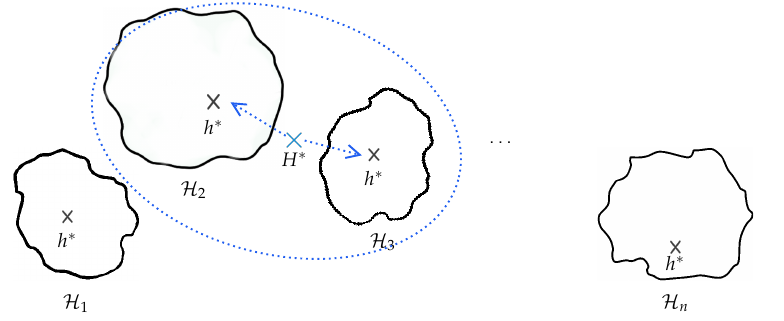
Figure 25. Illustration of the process of adaptation from the meta-hypothesis H ∗ towards a more appropriate hypothesis h ∗ (among those derived from the surrogate model) that matches the sensing configuration encountered by the deployed learning